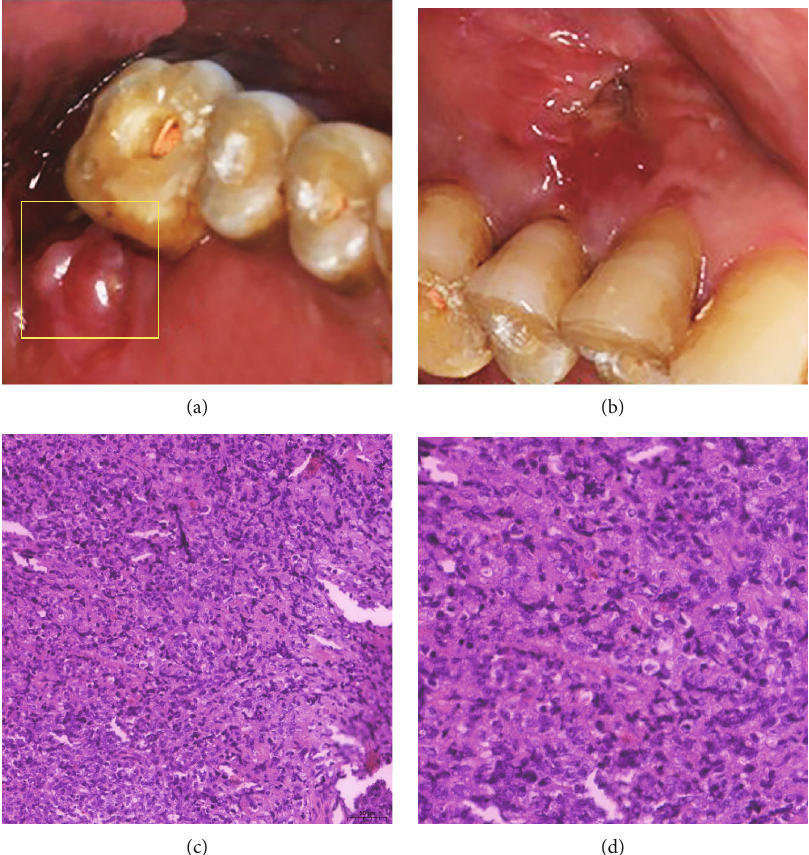
Figure 2: Two weeks after the fi rst visit, intraoral pictures showed the poorly healed extraction socket of #15 with surrounding, localized, conglobate nontender edema (a) and a soft, well-de fi ned, crater-like erythematous ulceration on the buccal gingiva of #13 and #14 (b). Histologic photomicrographs revealed a di ff usely in fi ltrating population of neoplastic lymphoid cells within a fi brotic stroma with vascular channels (c, 200x), and the majority of lymphocytes were large cells (d,